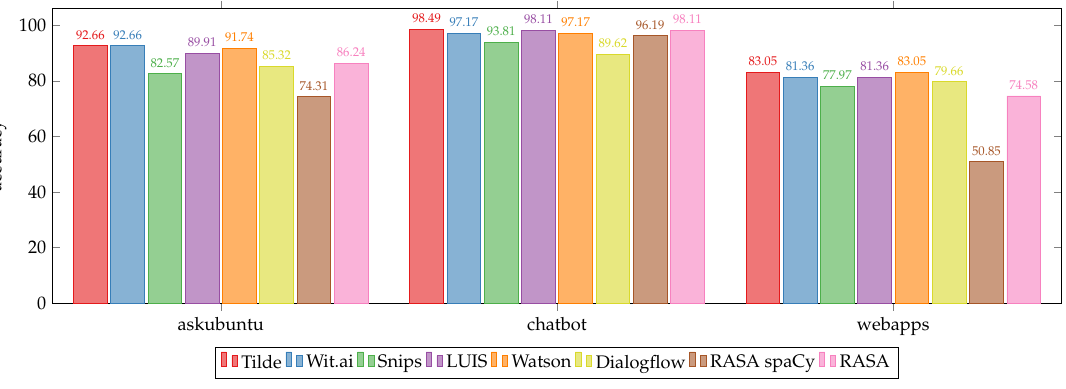
Figure 3. Intent detection accuracy (in percentages) of several dialogue system providers for the English